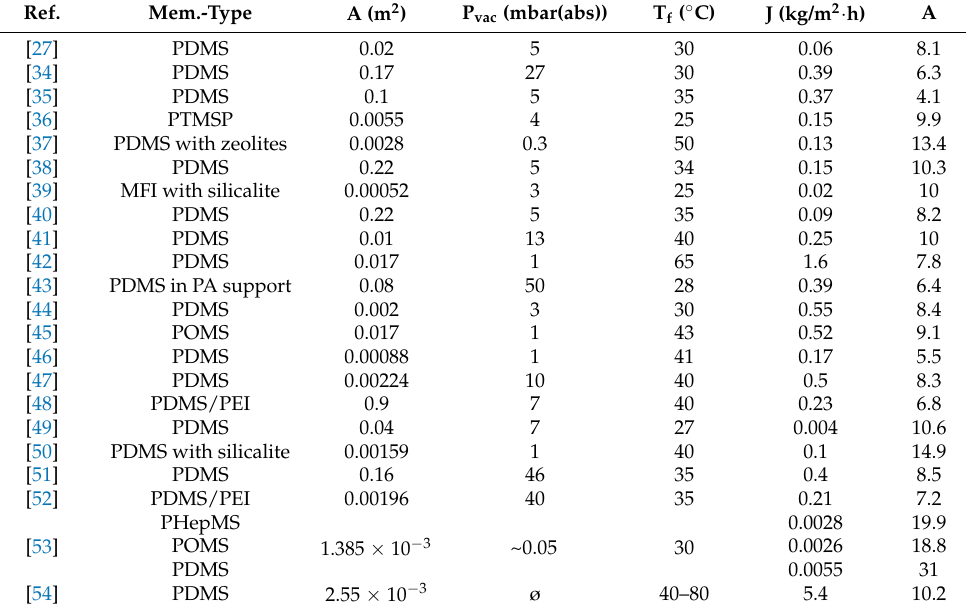
Table 3. Comparison study permeate flux and separation factor obtained from several previous studies using the pervaporation process for ethanol–water separation.